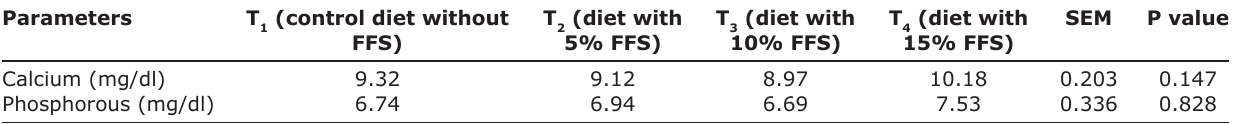
Table-6: Effect of dietary supplementation of FFS on serum mineral profile (mg/dl) of broiler Japanese quails at 5 weeks of age. Parameters